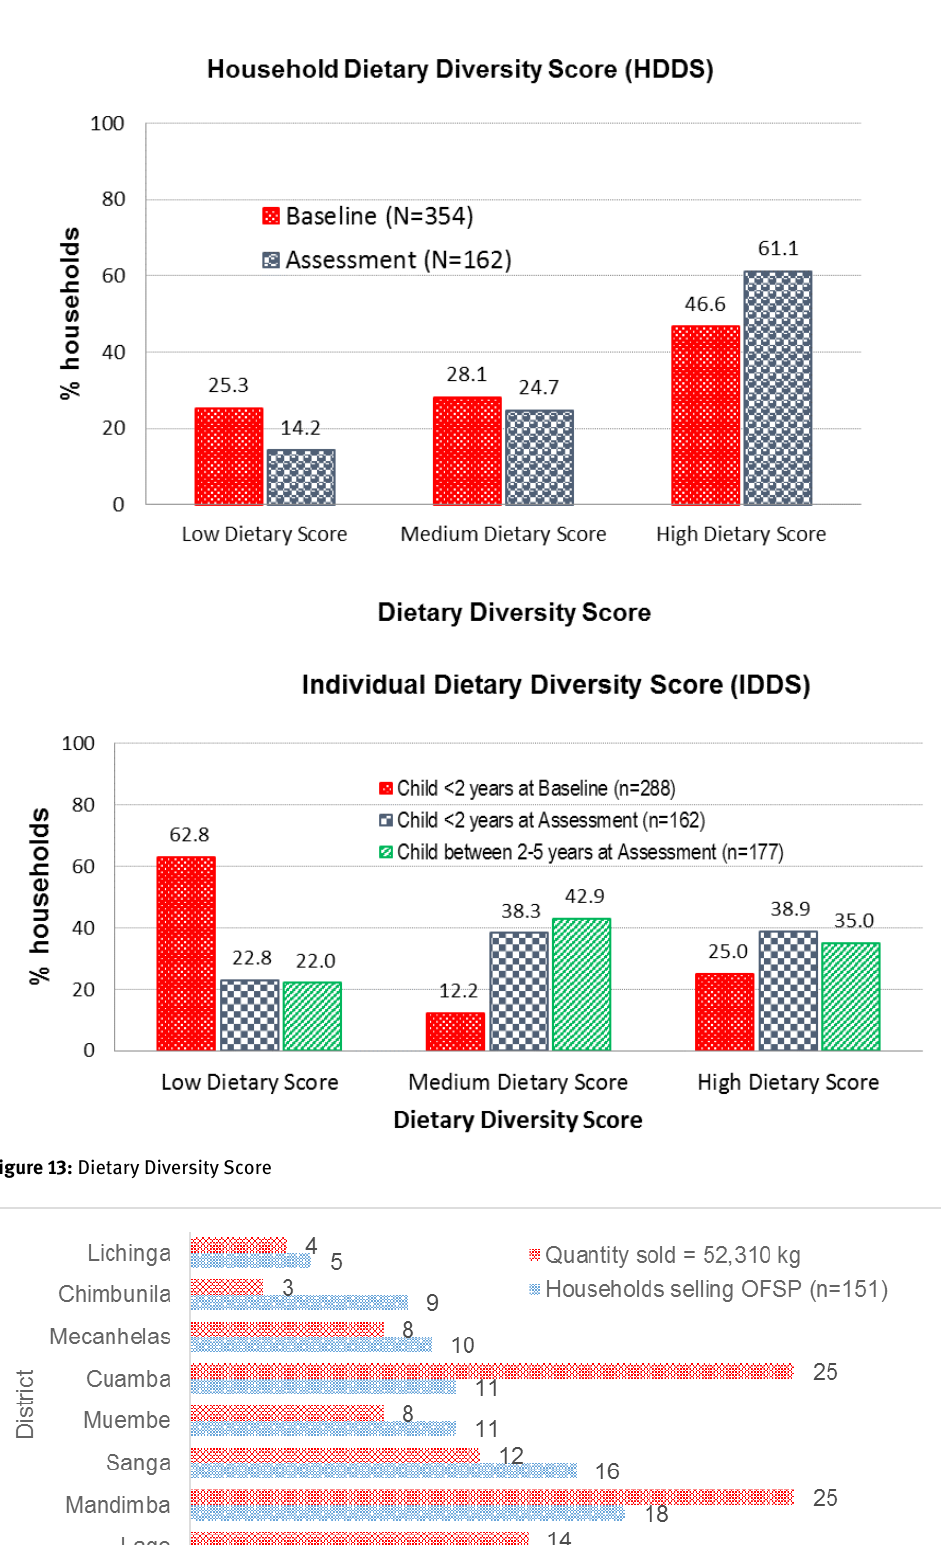
Figure 14: Households selling OFSP and quantity